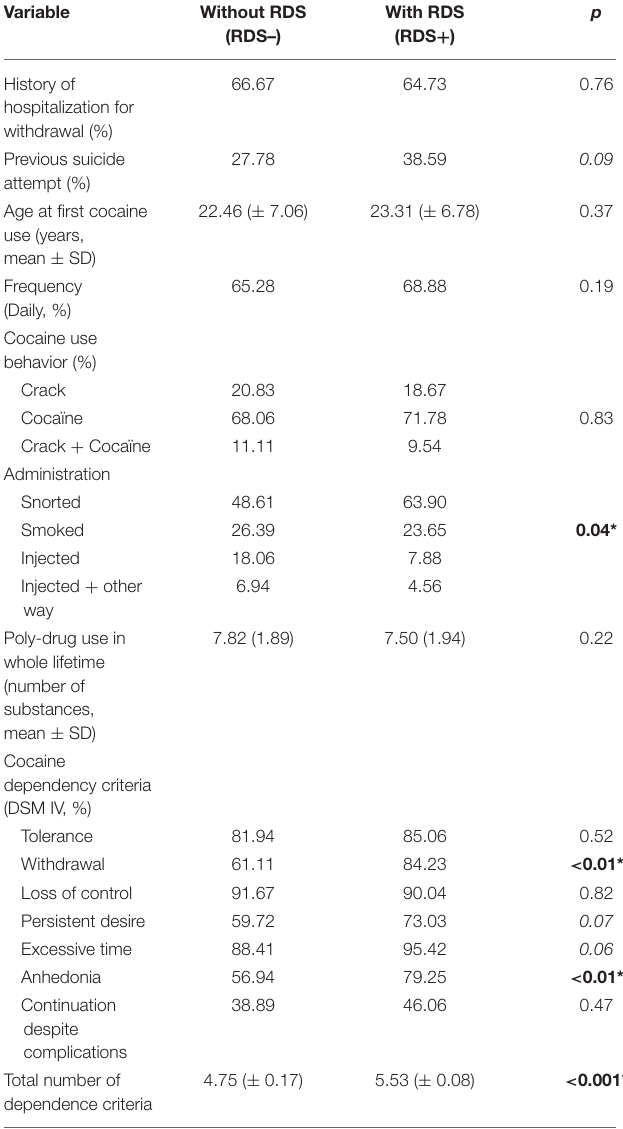
TABLE 1 | Sociodemographic characteristics and psychotic symptoms (assessed by SAPS-CIP) of cocaine users with (RDS + ) or without (RDS–) depressive symptoms during cocaine withdrawal.